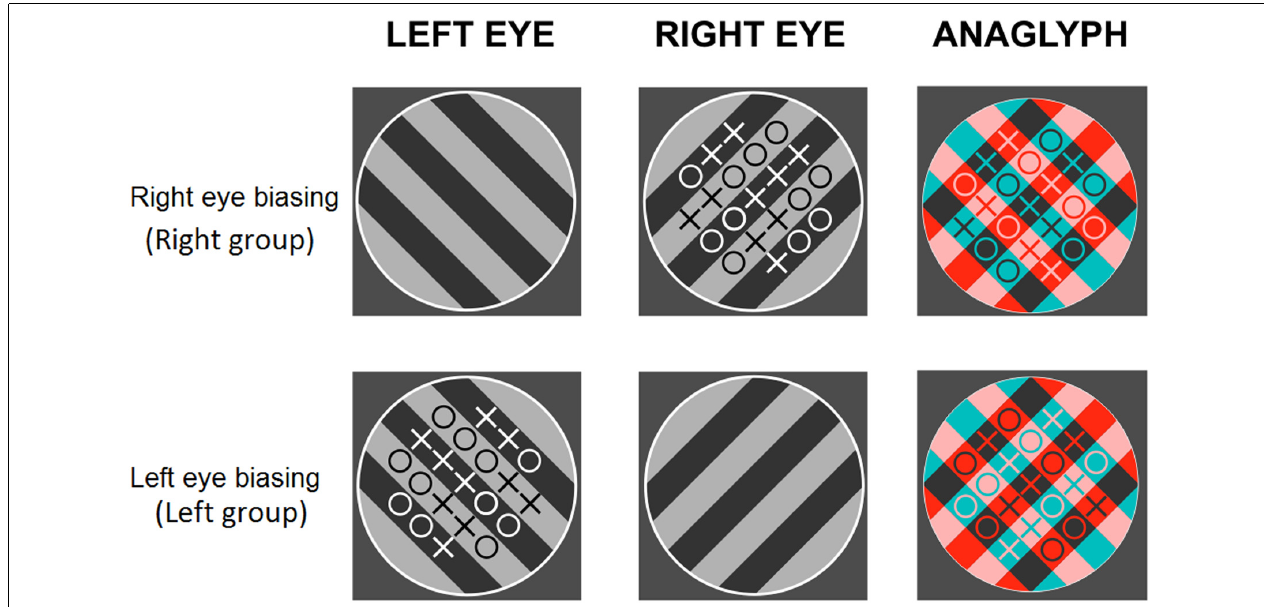
FIGURE 1 | Experiment 1. Examples of the counting task: anaglyphs for the right- (upper row) and left- (lower row) attended conditions.